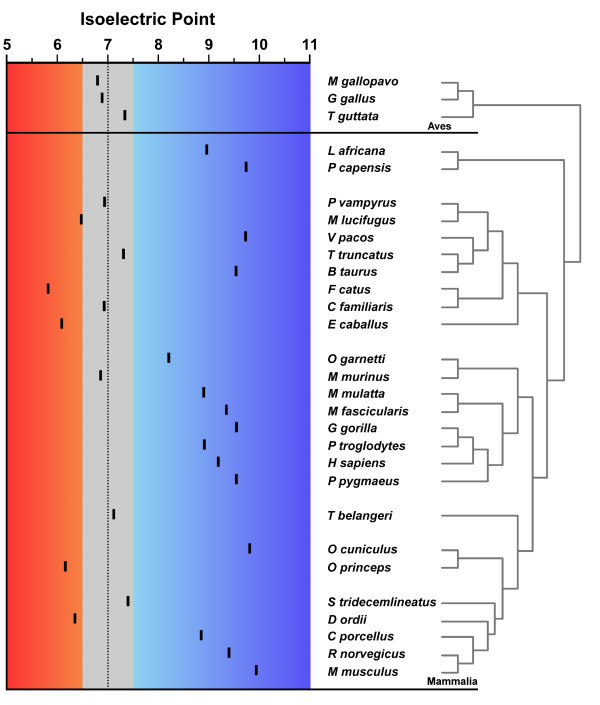
MEPE isoelectric points (pI) calculated for the 26 mammalian and 3 avian species. The red shadow represents the acid pI while the blue the basic pI, the grey shadow shows the nearly neutral proteins, from 6.5 to 7.5.